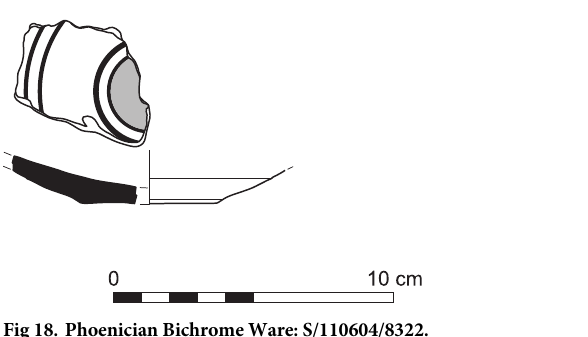
Fig 18. Phoenician Bichrome Ware: S/110604/8322.